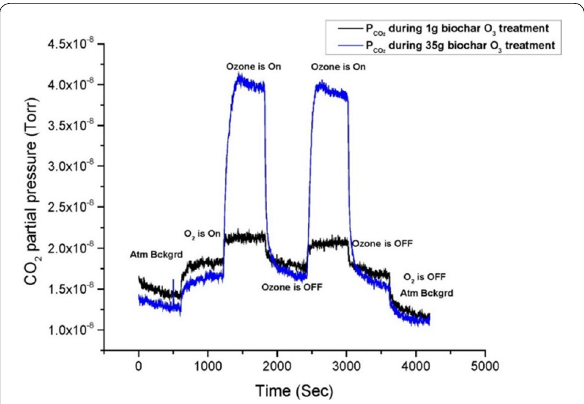
Fig. 2 Partial pressure of CO 2 versus time (s) during ozone treatments of 1 and 35 g biochar samples